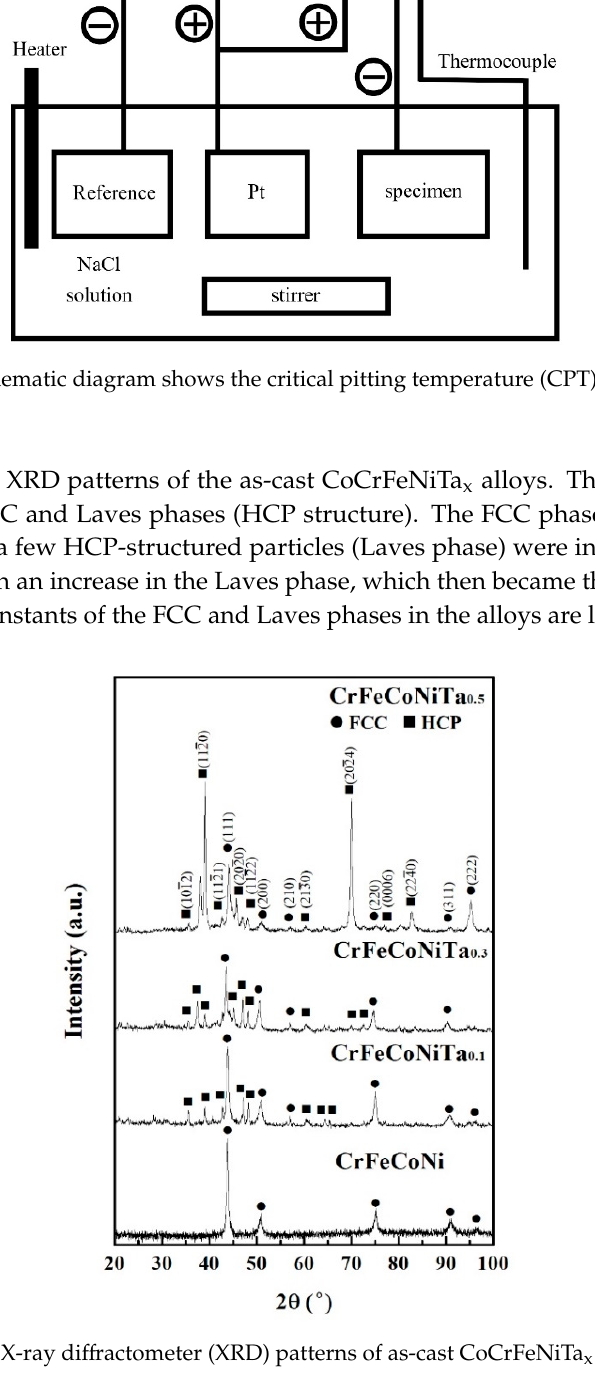
Figure 2. X-ray diffractometer ( XRD) patterns of as-cast CoCrFeNiTa x alloys.